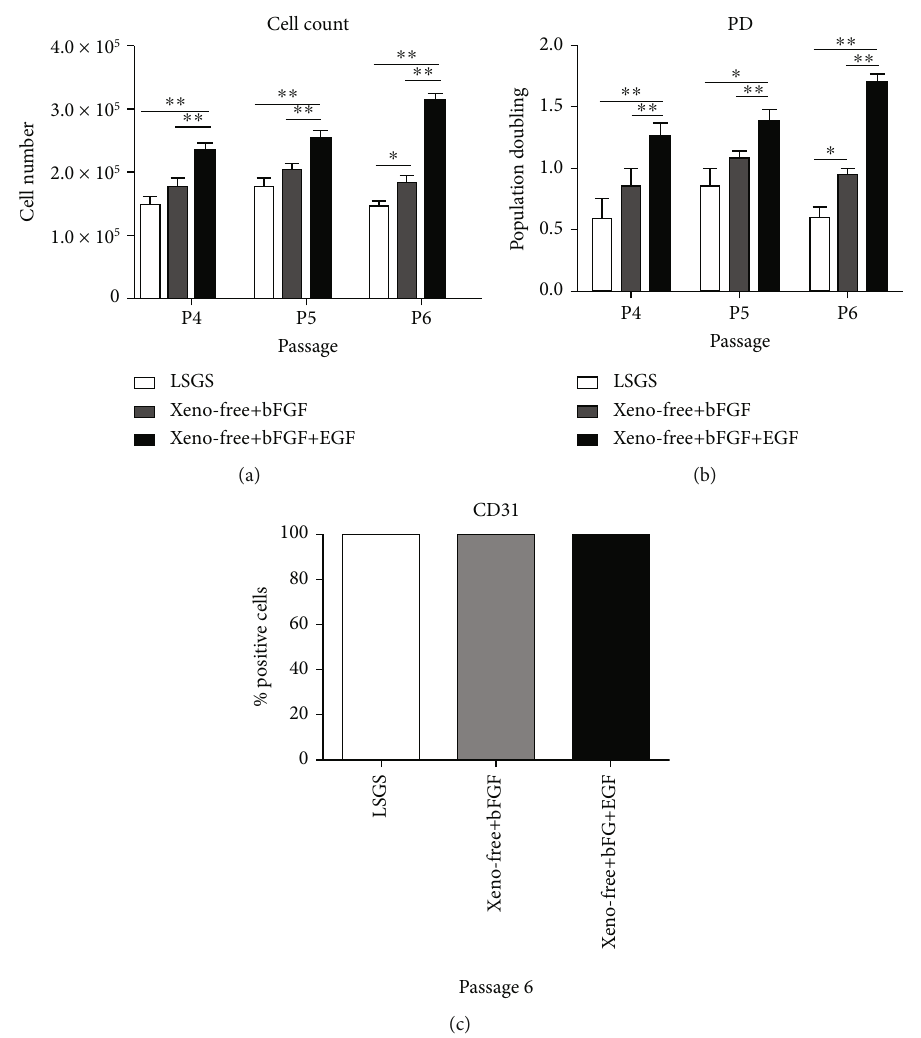
Figure 2: E ff ects of di ff erent culture constituents on growth kinetics and endothelial marker maintenance of HUVECs. Comparison of LSGS, xeno-free+bFGF, and xeno-free+bFGF+EGF culture media on cell proliferation (a) and population doubling (b) at passage 4, 5, and 6. At passage 6, HUVECs obtained from all three conditions still maintain the expression of CD31 (c). Data were expressed as mean ± SEM ( N = 3 ). Signi fi cant di ff erences at ∗ P < 0 : 05 and ∗∗ P < 0 : 01